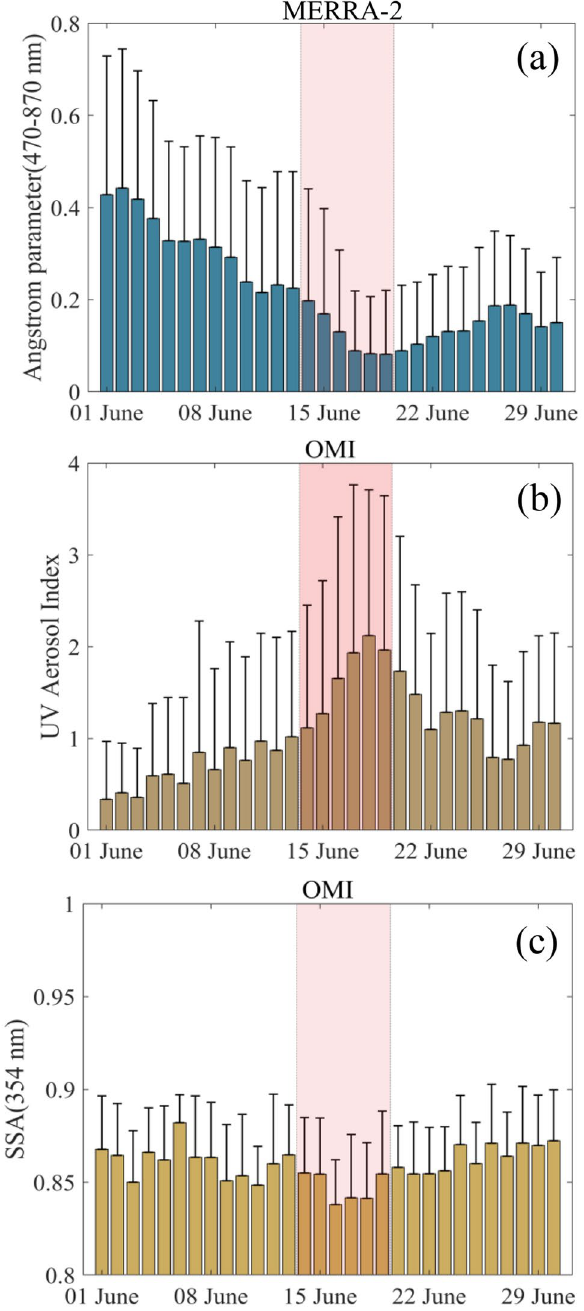
Figure 4. Area averaged time series of ( a ) Angstrom parameter from MERRA-2, ( b ) UV aerosol Index from OMI, ( c ) Single Scattering Albedo from OMI. The shading indicates the period of the dust storm. The error bars indicate + 1σ of the daily datasets over the selected area of interest. The map was generated using MATLAB 2015b, www. mathw orks.